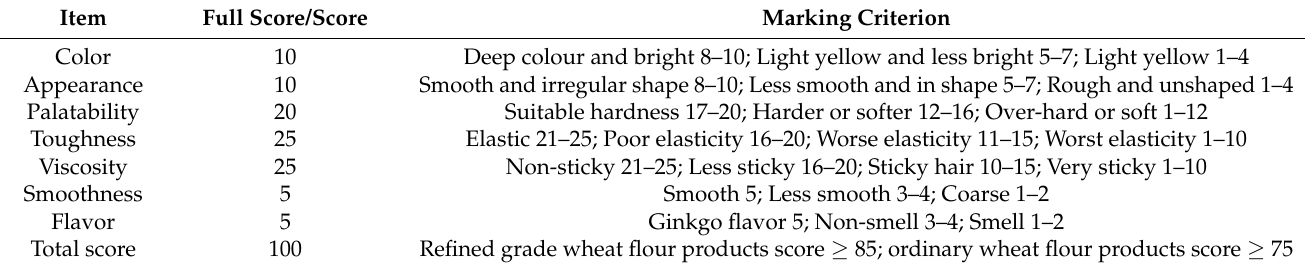
Table 1. Sensory evaluation standard of